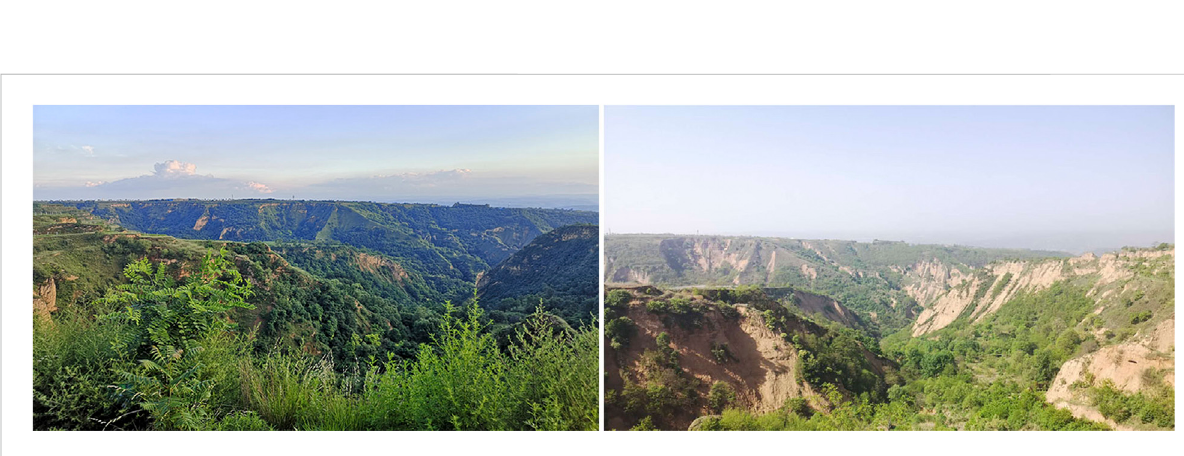
FIGURE 2 Natural landscape surrounding the Nantou Locale of